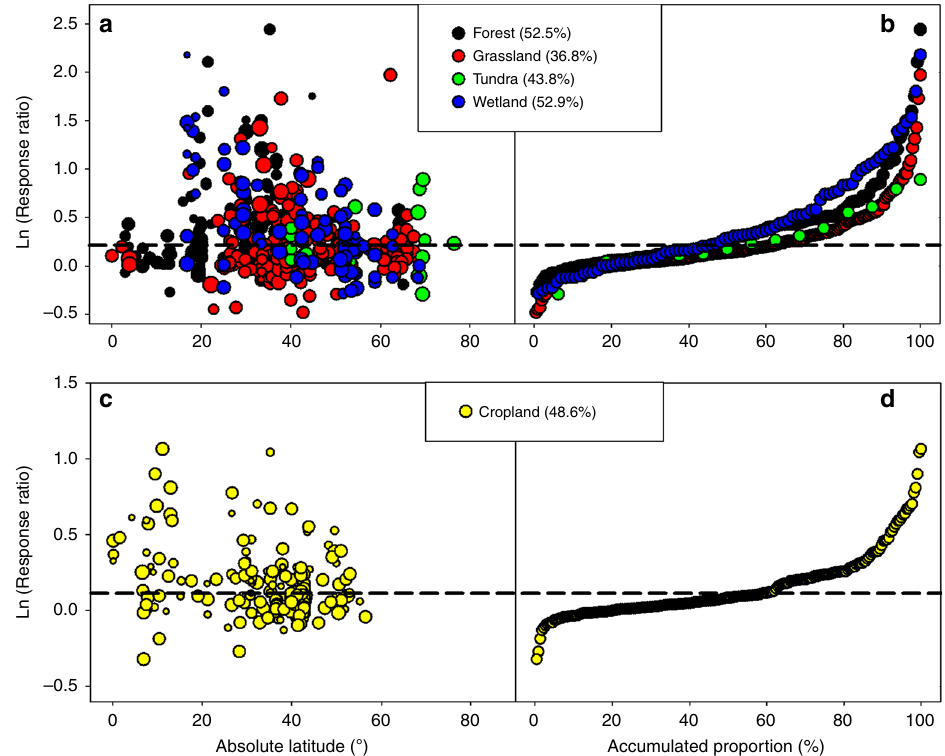
Fig. 2 Consistent occurrence of signi fi cant P limitation in all types of ecosystems. a Signi fi cant P limitation occurred in the natural terrestrial ecosystems at almost all latitudes. The magnitude of P limitation decreased with latitude in wetlands (meta-regression, R 2 = 0.35, P < 0.05, N = 85) but not in any other type of natural terrestrial ecosystem (meta-regression, P > 0.05). b Signi fi cant P limitation occurred in all types of natural terrestrial ecosystems. Values in the brackets indicate the percentage of signi fi cant P limitation cases in the total sample size in each type of natural terrestrial ecosystem. c Signi fi cant P limitation occurred in croplands at all explored latitudes (absolute latitude between 0.1 ° and 56.5 ° ), and the magnitude of P limitation decreased with absolute latitude (meta-regression, R 2 = 0.16, P < 0.05, N = 216). d Signi fi cant P limitation was found in 48.6% of the P-fertilization experiments in the croplands. As in Fig. 1, statistical signi fi cance of P limitation was assessed based on the Ln(Response Ratio). Dashed lines in all plots (0.23 in ( a ) and ( b ), 0.09 in ( c ) and ( d )) indicate where the magnitude of P limitation approximates a 0.05 signi fi cance level ( Z test). In ( a ) and ( c ), the size of each point is proportional to the weight used for meta-regression analysis. Source data are provided as a Source Data fi